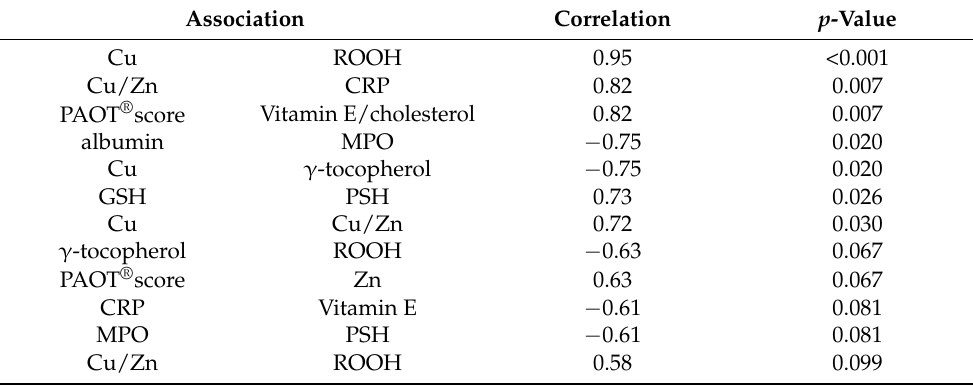
Table 5. Correlation between some OS biomarkers as observed in COVID-19 patients. ROOH: lipid peroxides, CRP: C-reactive protein, MPO: myeloperoxidase, PSH: thiol proteins, Cu: copper, Zn: zinc.